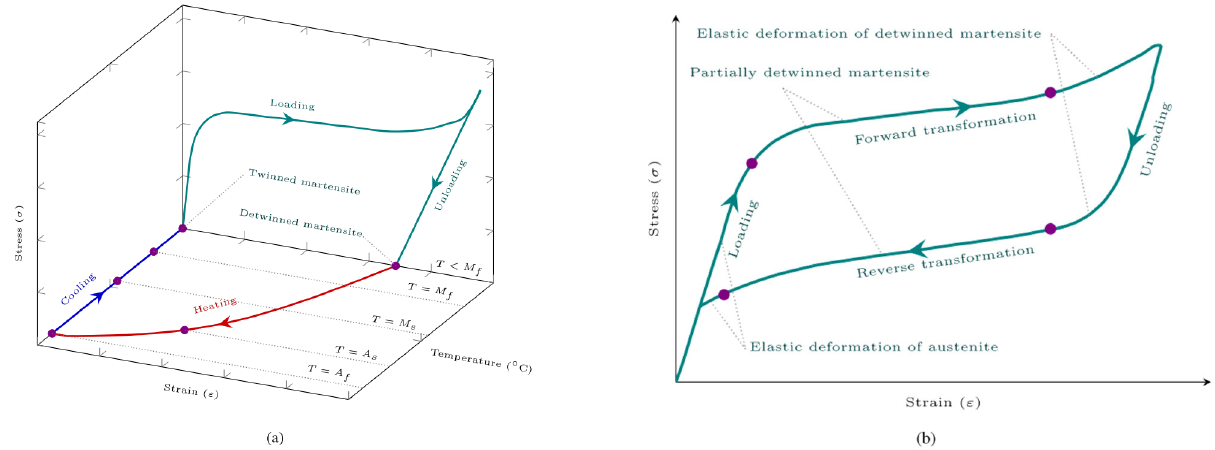
Figure 4. Stress–strain–temperature curves for ( a ) shape memory effect and ( b ) super-elasticity